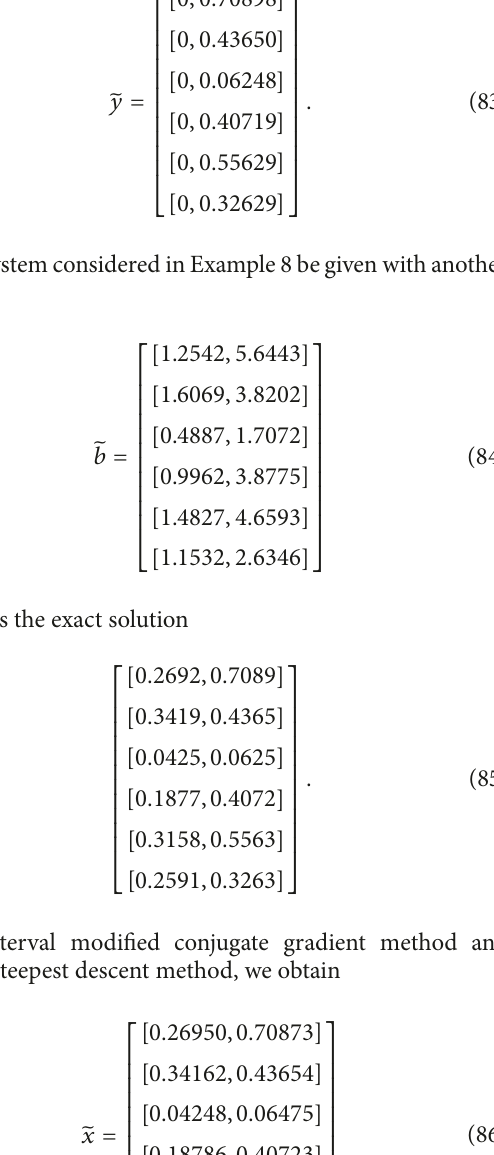
Figure 1: Tightness of solutions and convergences of our methods.